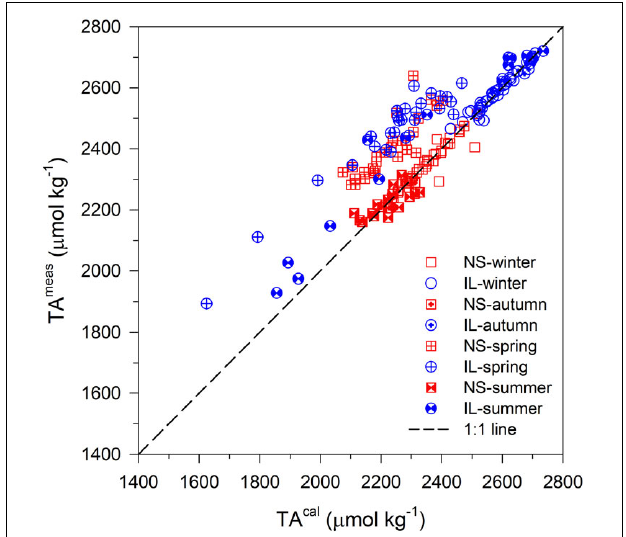
FIGURE 8 | Comparison of the measured TA (TA meas ) by direct titration and the TA calculated (TA cal ) from the measured DIC and pH in the inner lagoon (IL; circles), and on the northern shore (NS; squares). The difference between TA meas and TA meas ( (cid:49) TA) denotes organic TA (TA org ; see text for